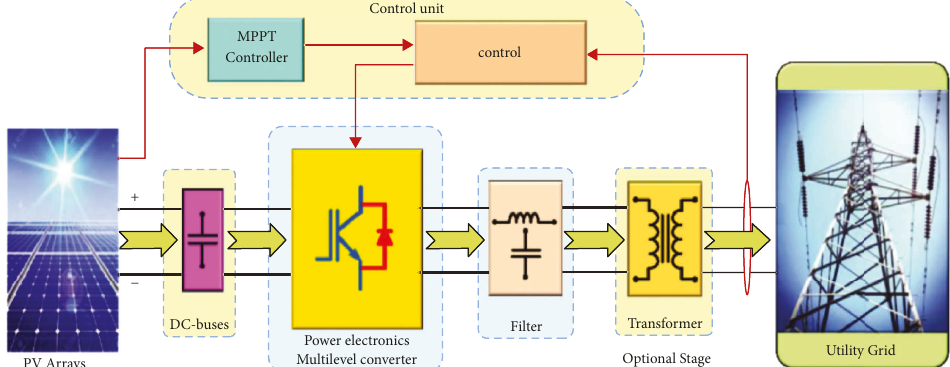
Figure 7: Block diagram of the on-grid photovoltaic system (source [9]).